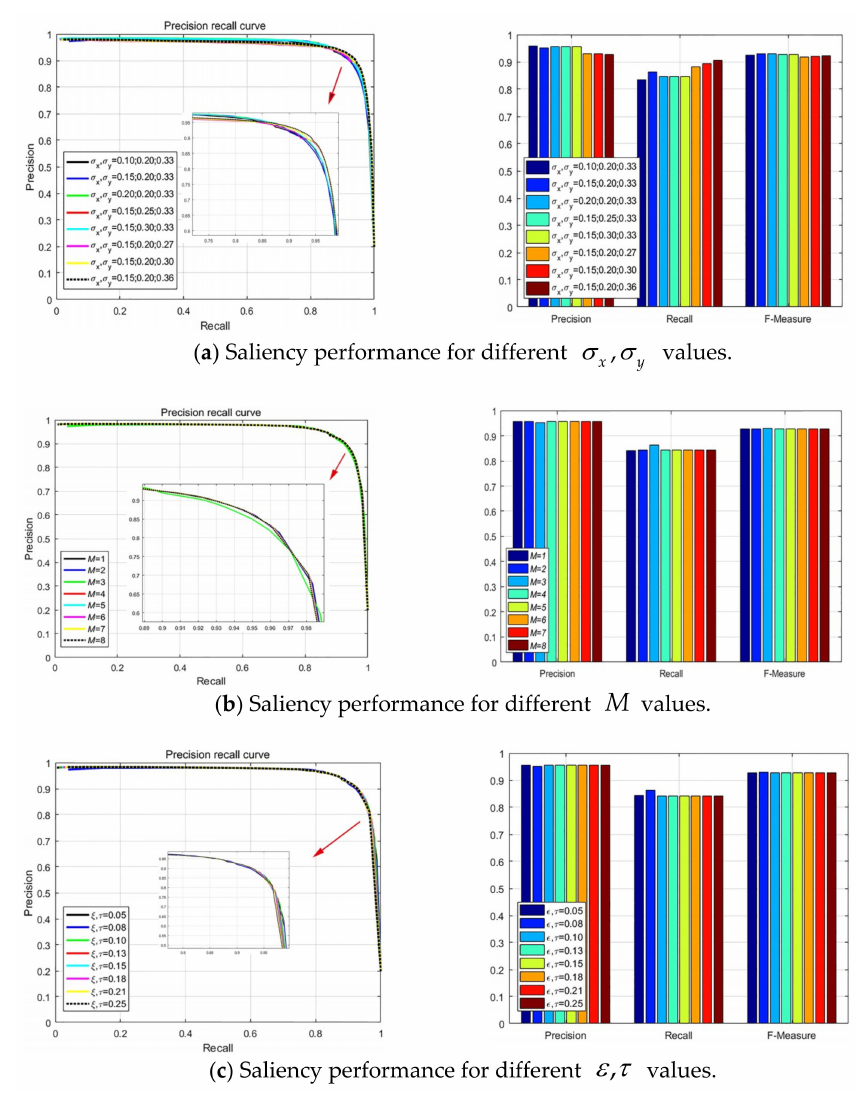
Figure 9. Saliency performance for different parameter settings. Left: precision-recall curves; Right: precision, recall, and F-measure at adaptive threshold. ( a ) σ x , σ y , ( b ) M , ( c ) ε , τ